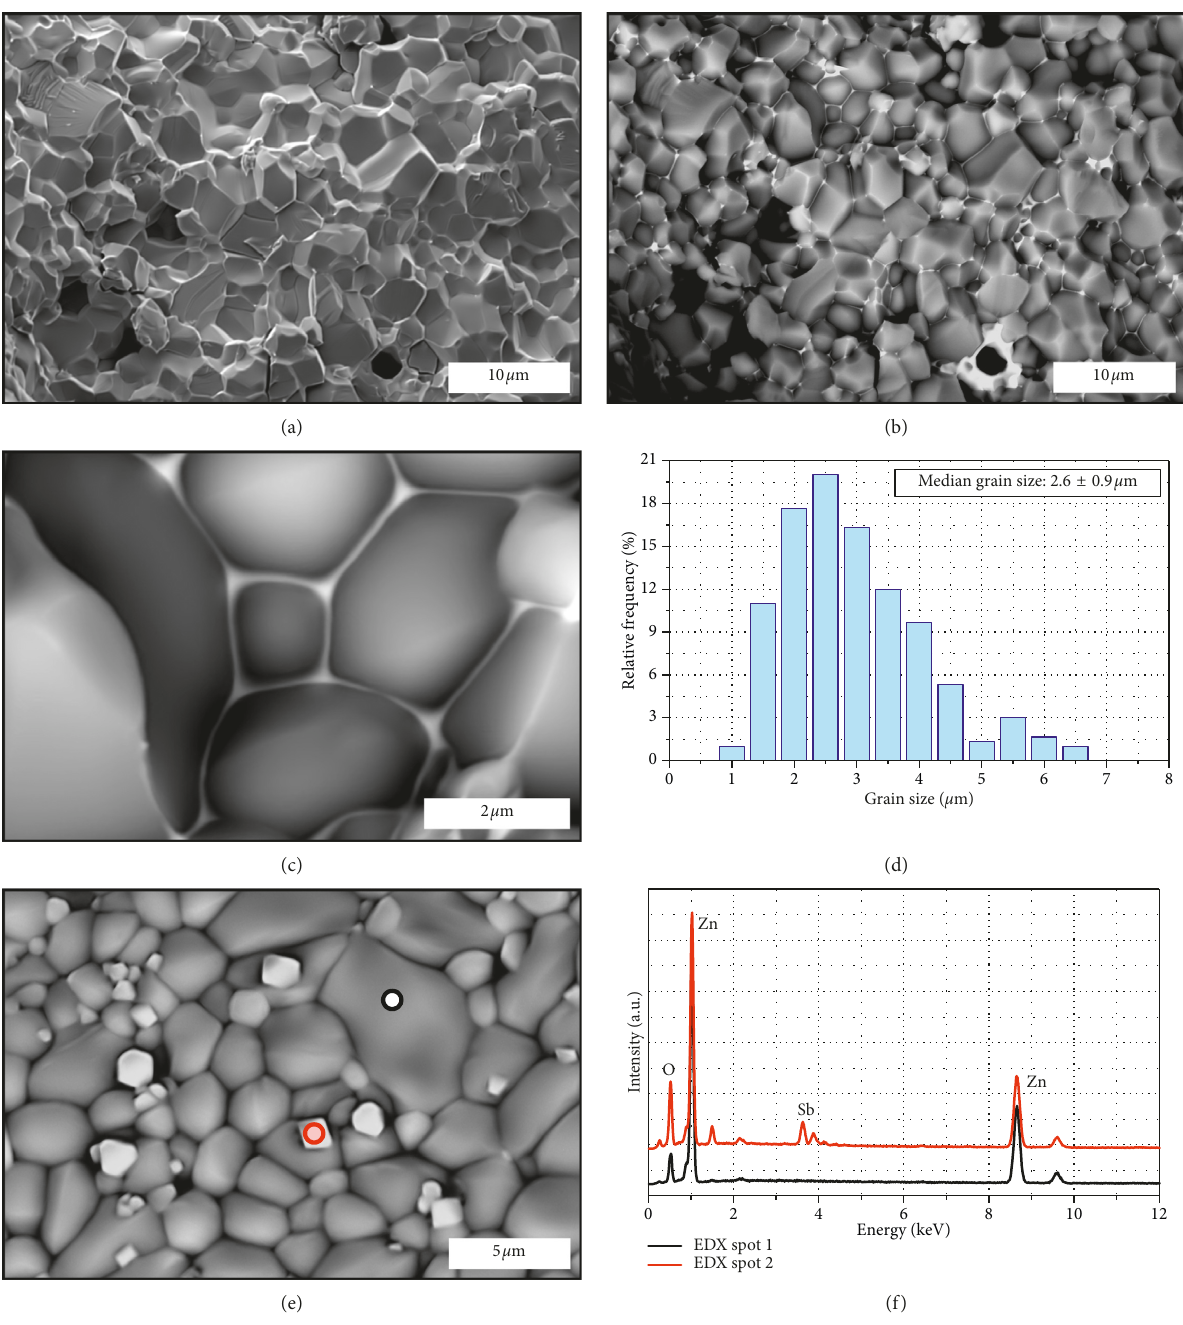
Figure 2: SEM micrographs of the strut fracture surface in zinc oxide ceramic foams: (a) SE image, (b, c) BSE images revealing the Bi- containing secondary phase in the grain boundaries, (d) grain size distribution in the ZnO strut material, and (e, f) BSE micrograph and EDS spectra of the strut surface (black ○ ) and of individual grains of a Sb-containing secondary phase (red ○